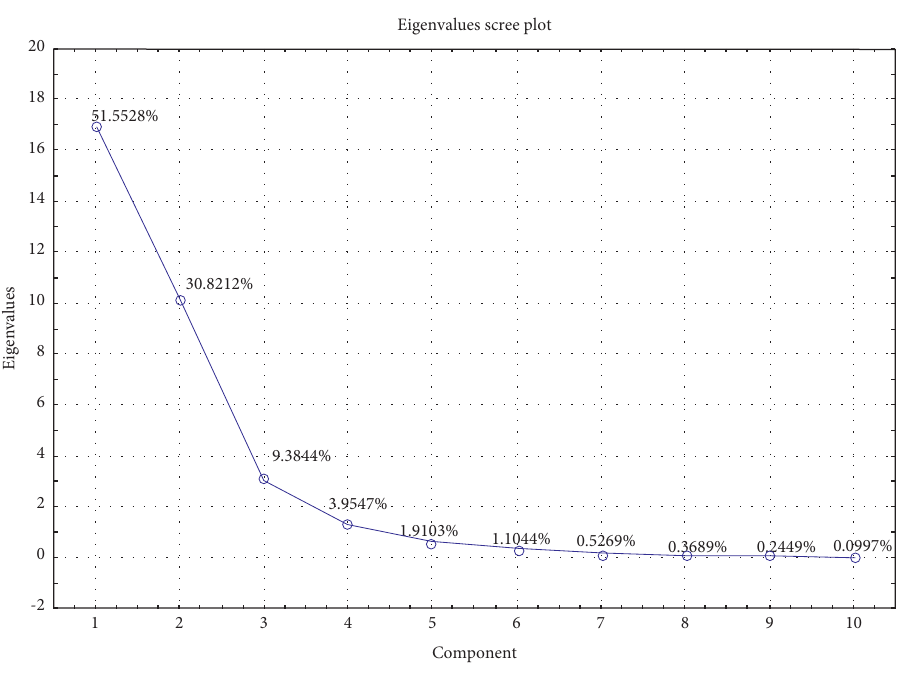
Figure 2: Eigenvalues scree